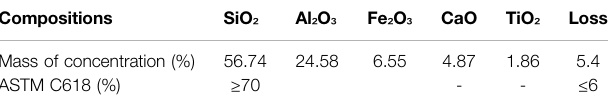
TABLE 3 | Chemical composition of fl y